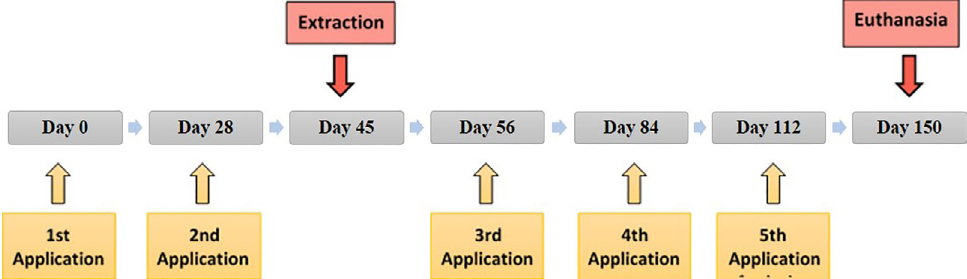
Figure 1- Outline of applications, surgical procedure, and euthanasia, related to